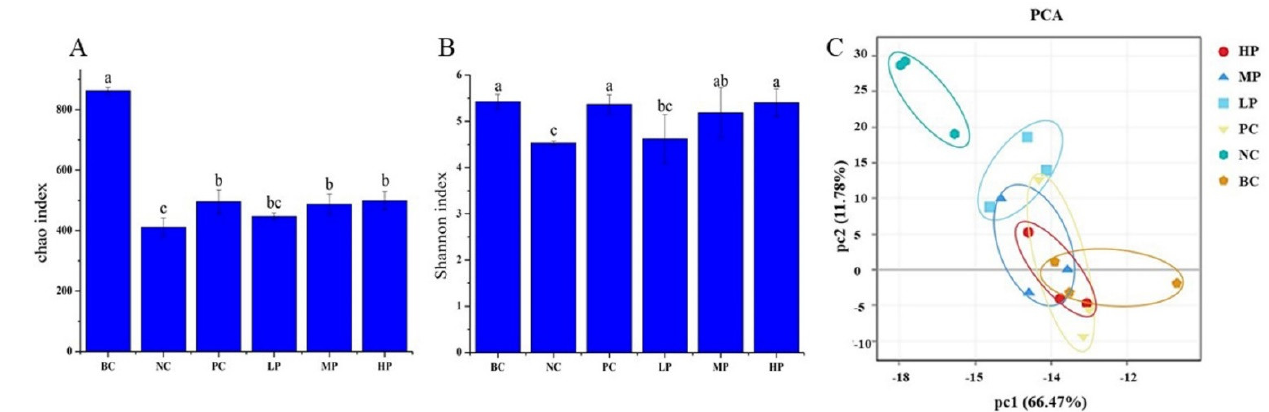
Figure 4. The analysis of abundance and diversity of the gut microbiota: ( A ) Chao index; ( B ) Shannon index; ( C ) principal component analysis (PCA) score plot. BC (blank control) represents healthy mice; NC (negative control) represents AAD mice without treatment; PC (positive control) represents AAD mice administrated with 200 mg/kg BW of inulin; LP, MP and HP represent AAD mice administrated with low-dosage (100 mg/kg BW), middle-dosage (200 mg/kg BW) and high-dosage (400 mg/kg BW) of BSP, respectively. a–c: Graph bars marked without the same letters differed significantly ( p < 0.05). The values are expressed as means ± S.D.